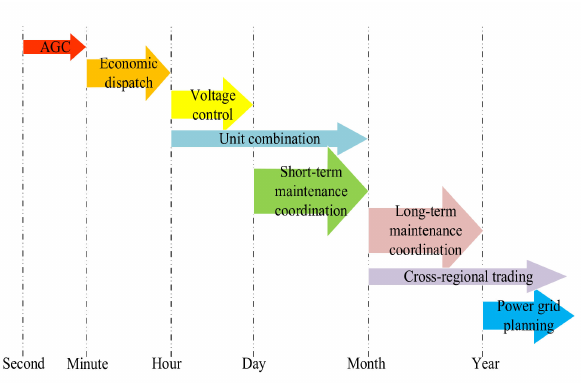
Figure 1. Control actions at di ff erent time